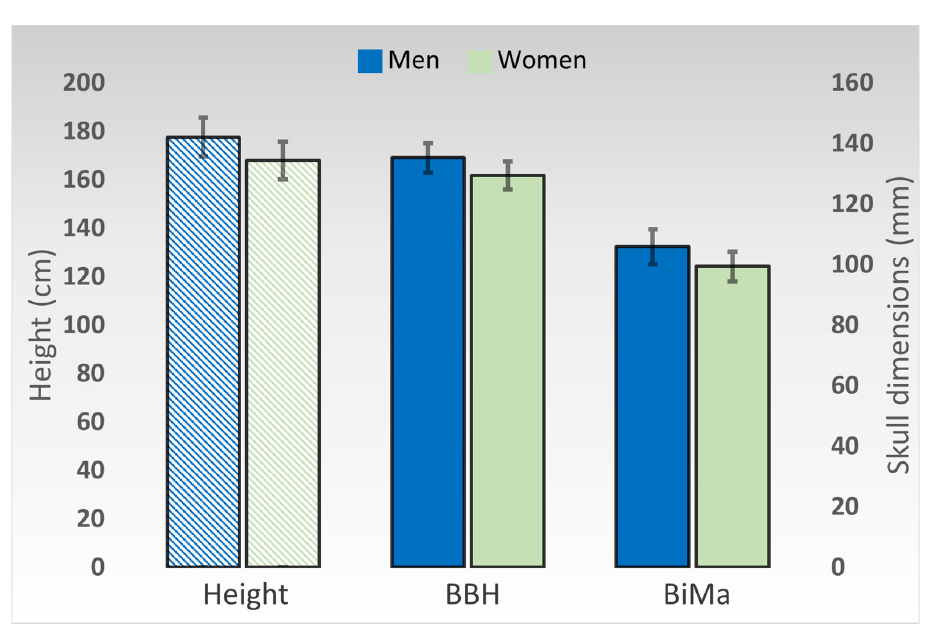
Figure 3. Graphical representation of the differences in average patient height and skull measure- ments between genders. Height is represented on the primary axis, in centimeters. Cranial diameters are represented on the secondary axis, in millimeters. Error bars represent standard deviations. BBH—height between the basion and the bregma. BiMa—bimastoid width.